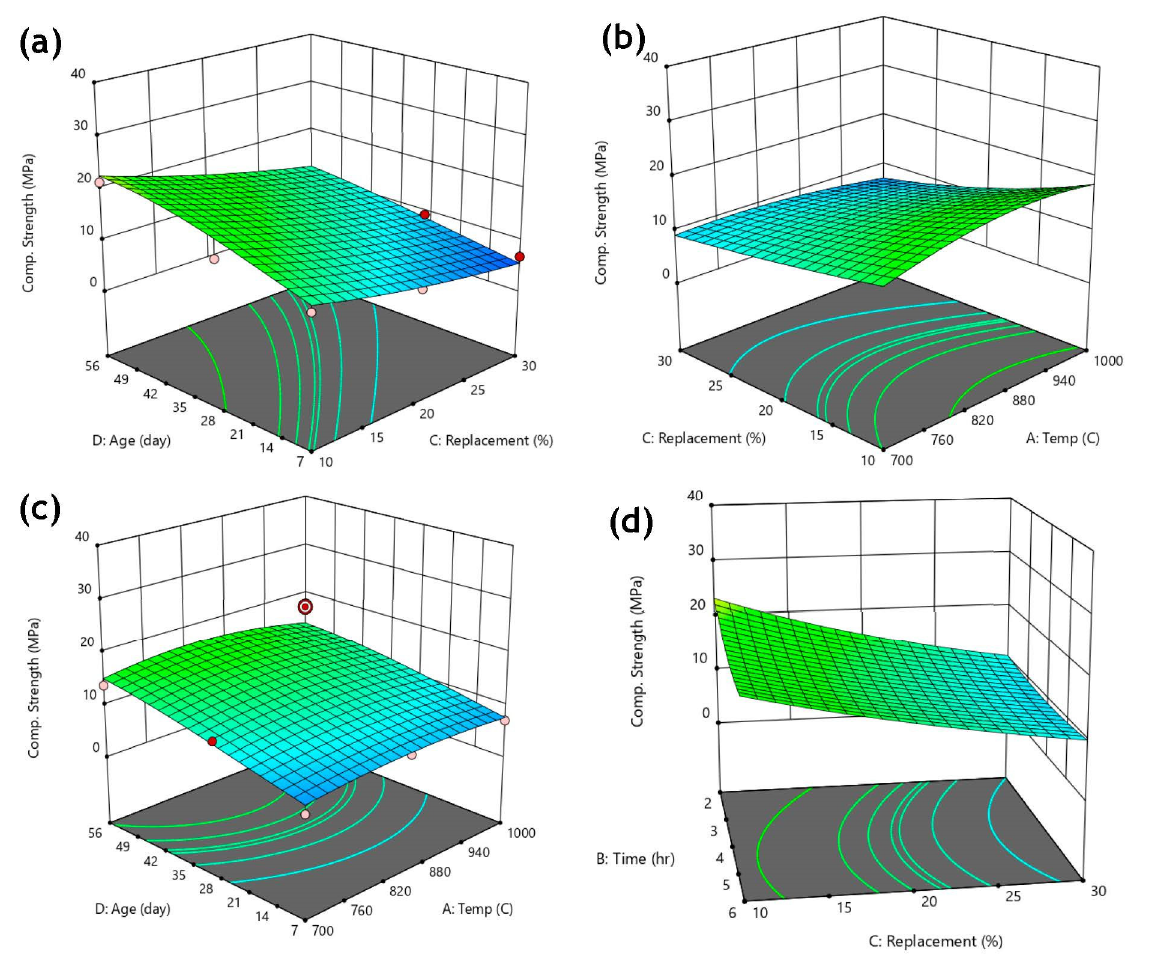
Figure 12. Response surface 3-dimensional contour plots to: ( a ) percentage of replacement vs. curing age, ( b ) calcination temperature vs. percentage of replacement, ( c ) calcination temperature vs. curing age, ( d ) percentage of replacement vs. calcination time.